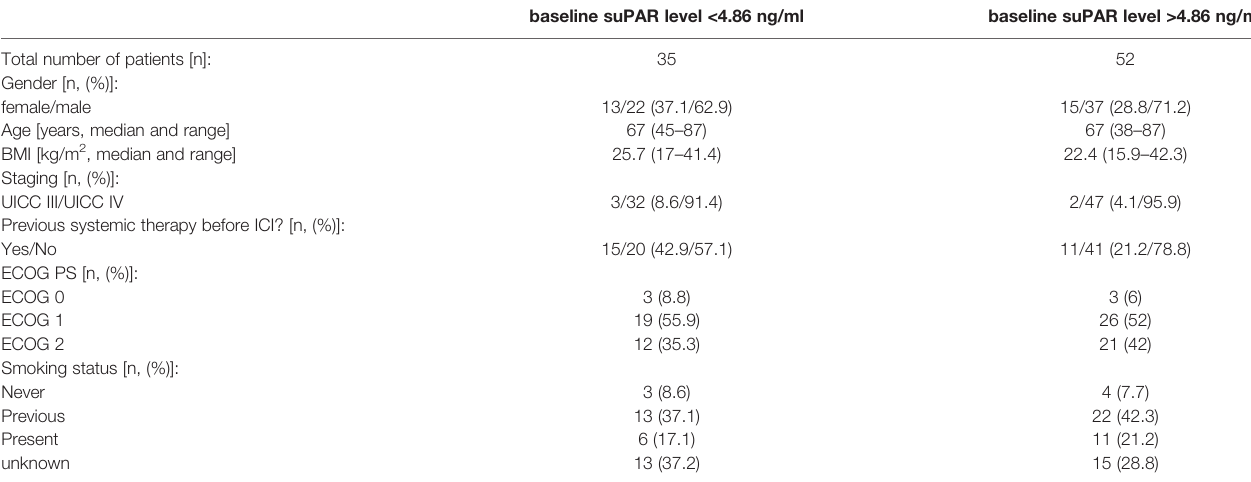
TABLE 3 | Comparison of clinical and pathological factors among patients with baseline suPAR levels below/above the ideal prognostic cut-off